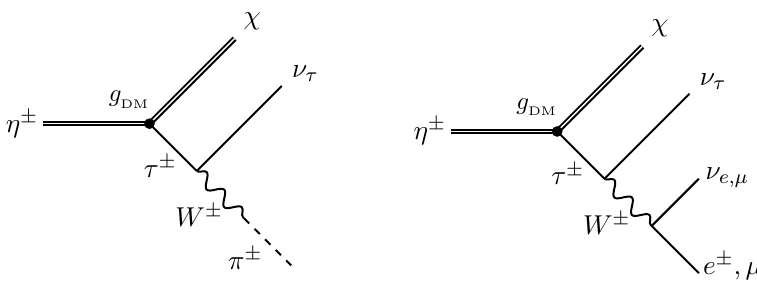
Figure 4 . The 3-body and 4-body (cid:17) -decays via an o(cid:11)-shell (cid:28) (and W ).